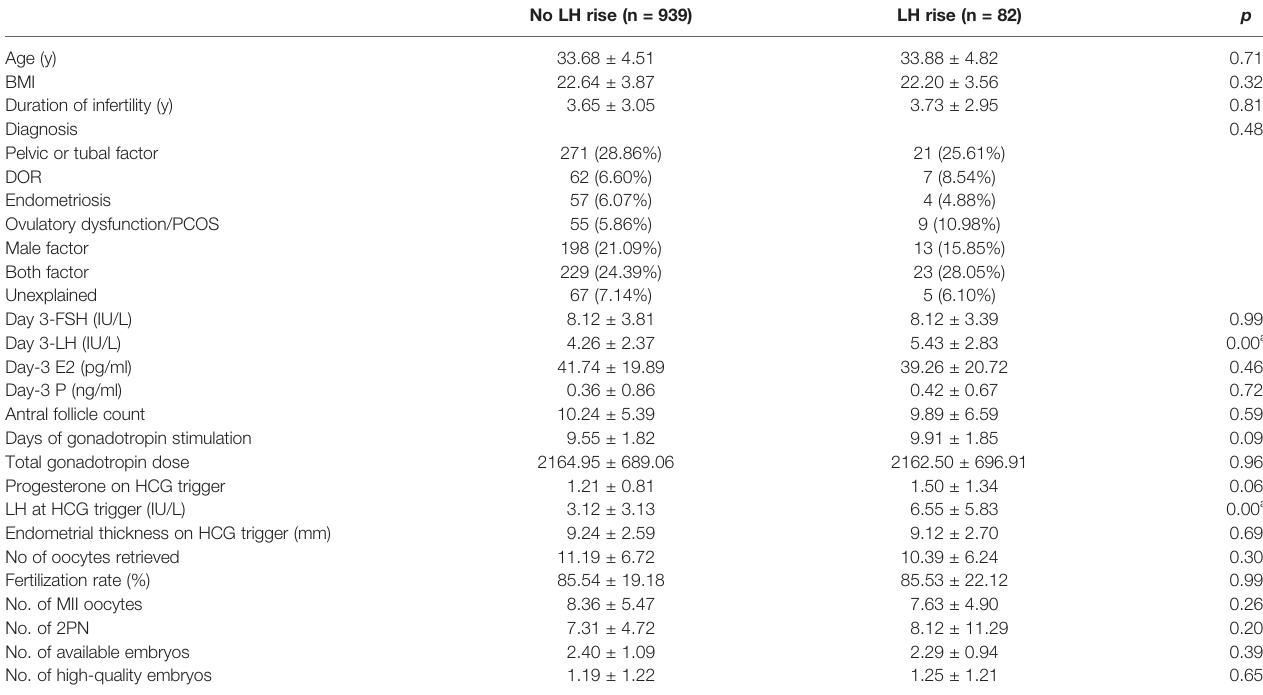
TABLE 1 | A comparison of baseline characteristics between cycles with and without a premature rise in LH